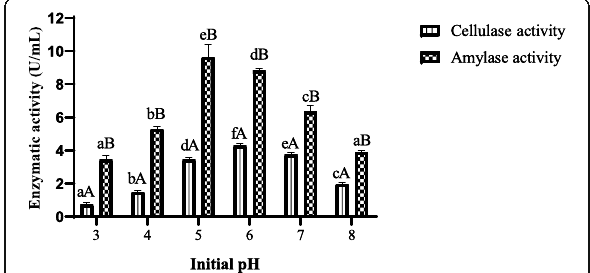
Fig. 2 Effect of initial pH on production of amylase and cellulase enzymes by A. niger ASP2. Values are mean ± standard error of triplicates. a – f Means in same column of each parameter with different lower case letters differed significantly ( p < 0.05). A, B Values in the enzymatic activity (cellulase and amylase) for each parameter with different lower case letters differed significantly ( p < 0.05)